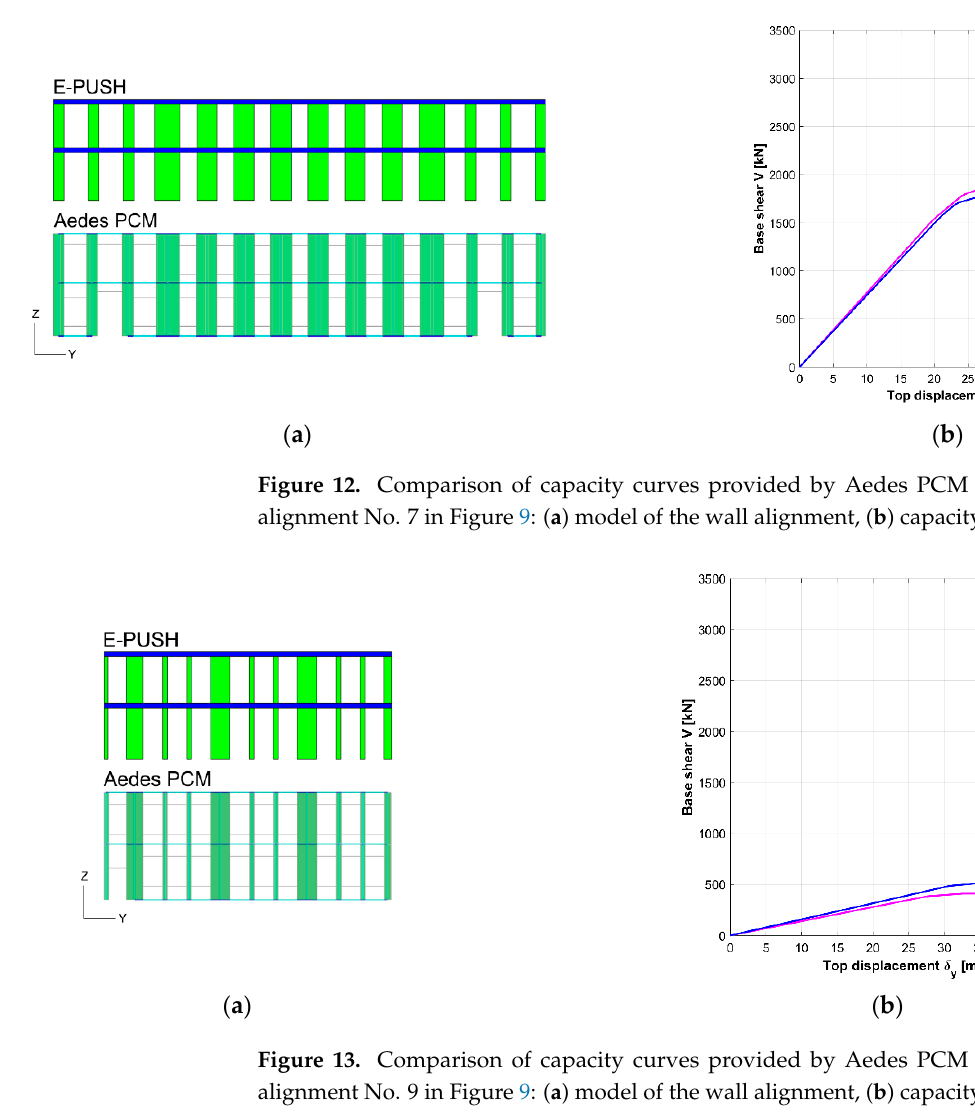
Figure 11. Comparison of capacity curves provided by Aedes PCM and E-PUSH for the wall alignment No. 5 in Figure 9: ( a ) model of the wall alignment, ( b ) capacity curves.